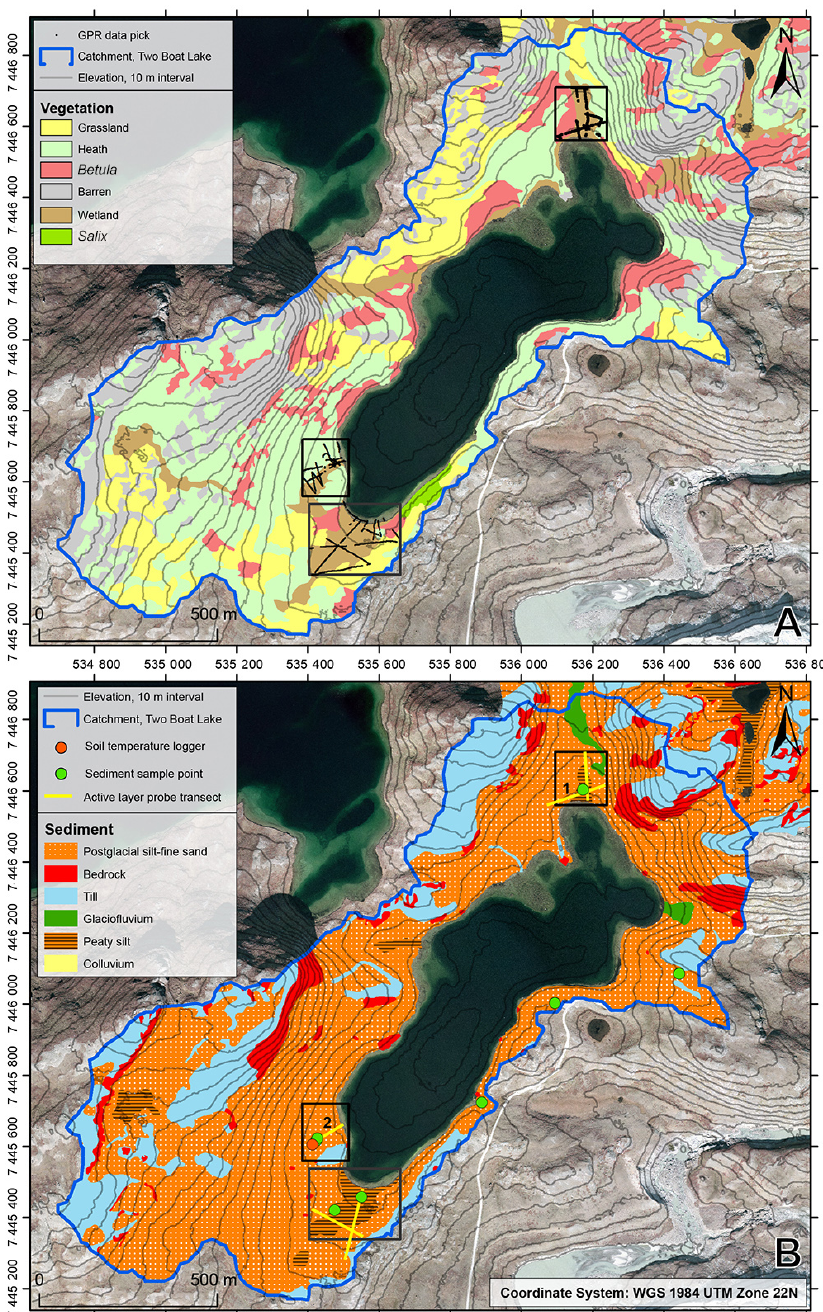
Figure 3. (a) Vegetation map of the catchment outlined in black with defined sub-areas and selected GPR data points. (b) The aerial distribution of sediment classes and bedrock outcrops within the catchment in addition to field measurements. Spatial distributions are from Clarhäll